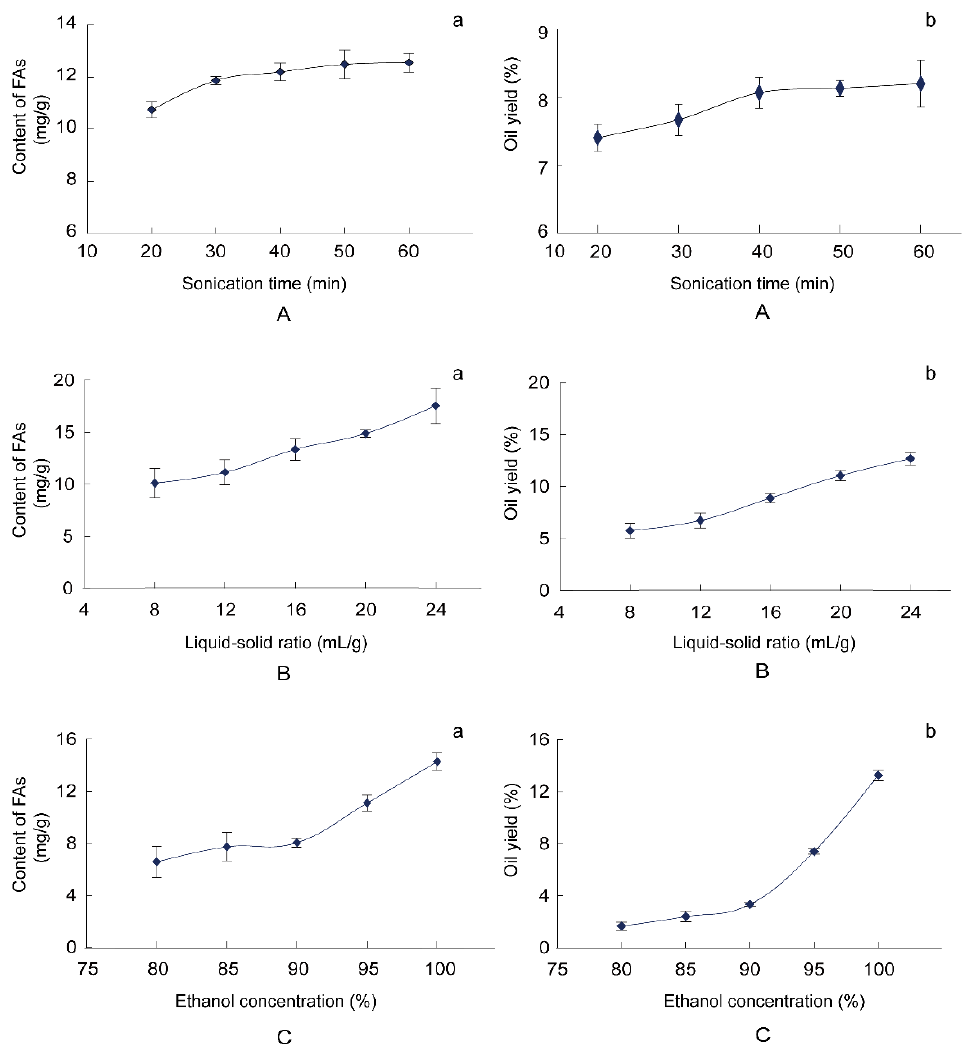
Figure 2. Effects of different factors on content of FAs and oil yield. The effects of sonication time (min), liquid-solid ratio (mL/g), and ethanol concentration (%) are shown in A , B , and C , respectively. The content of FAs (mg/g) and the oil yield (%) are shown in a and b, respectively. Data are shown as mean ± SD ( n = 3).